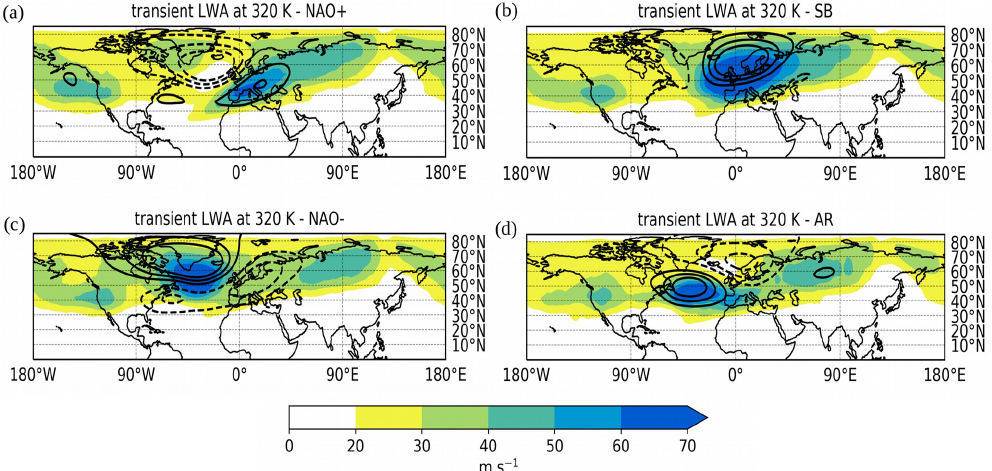
Figure 6. Transient LWA (colour, units ms − 1 ) and Montgomery stream function anomalies (black contours at 500, 1000 and 1500m 2 s − 2 ; dashed contours represent negative values; the zero contour is omitted) at 320K associated with the four WRs over the EAT sector during winter in